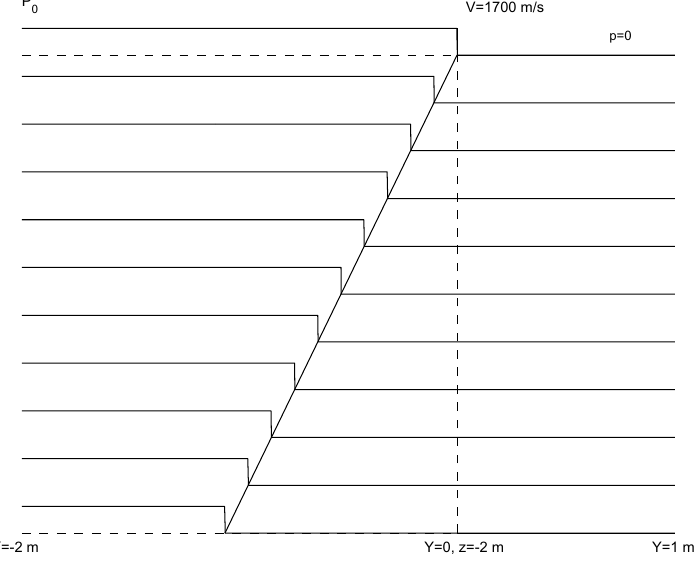
Fig. 3. Acoustic pressure in a half space of liquid loaded by a supersonic pressure